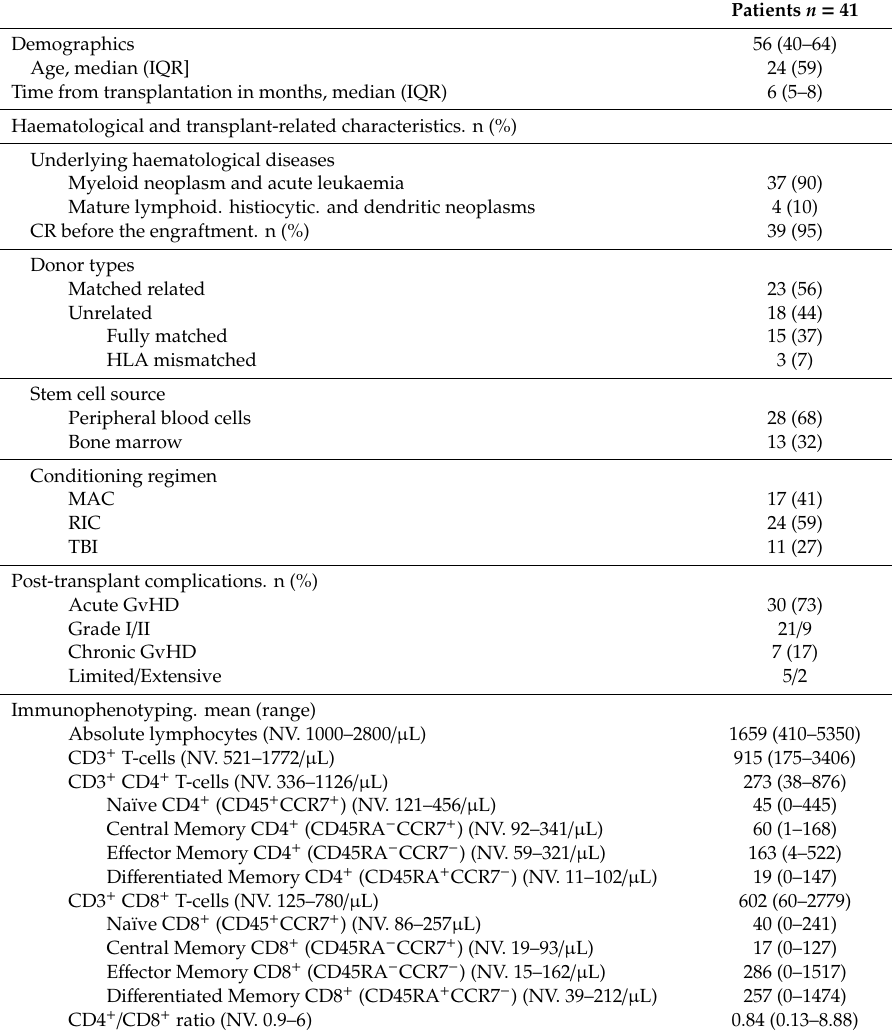
Table 1. Clinical characteristics of allogeneic haematopoietic stem cell transplant